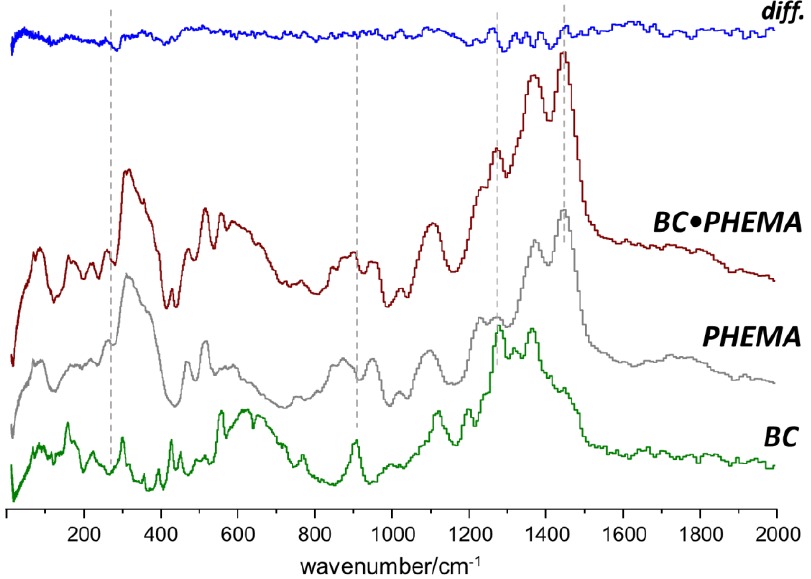
Figure 5. INS spectra of BC•PHEMA nanocomposite, PHEMA and BC in the 20–2000 cm −1 range. The top line is the difference between nanocomposite spectrum (BC•PHEMA) and the weighted sum